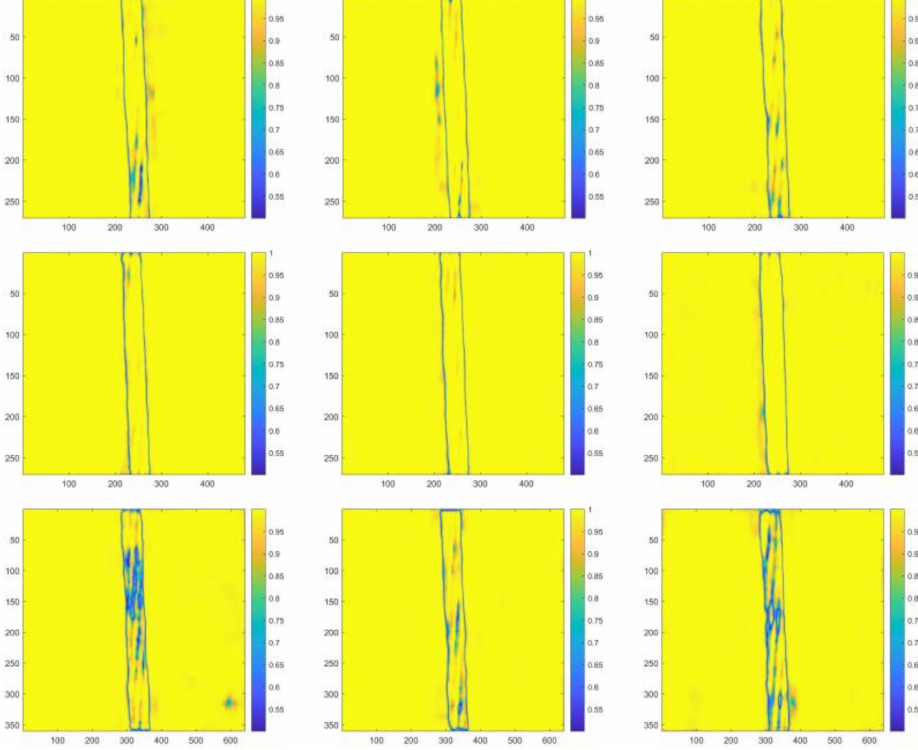
Figure 13. Visualized segmentation results in the heat map form of the same representative testing image with the C-T ratio of